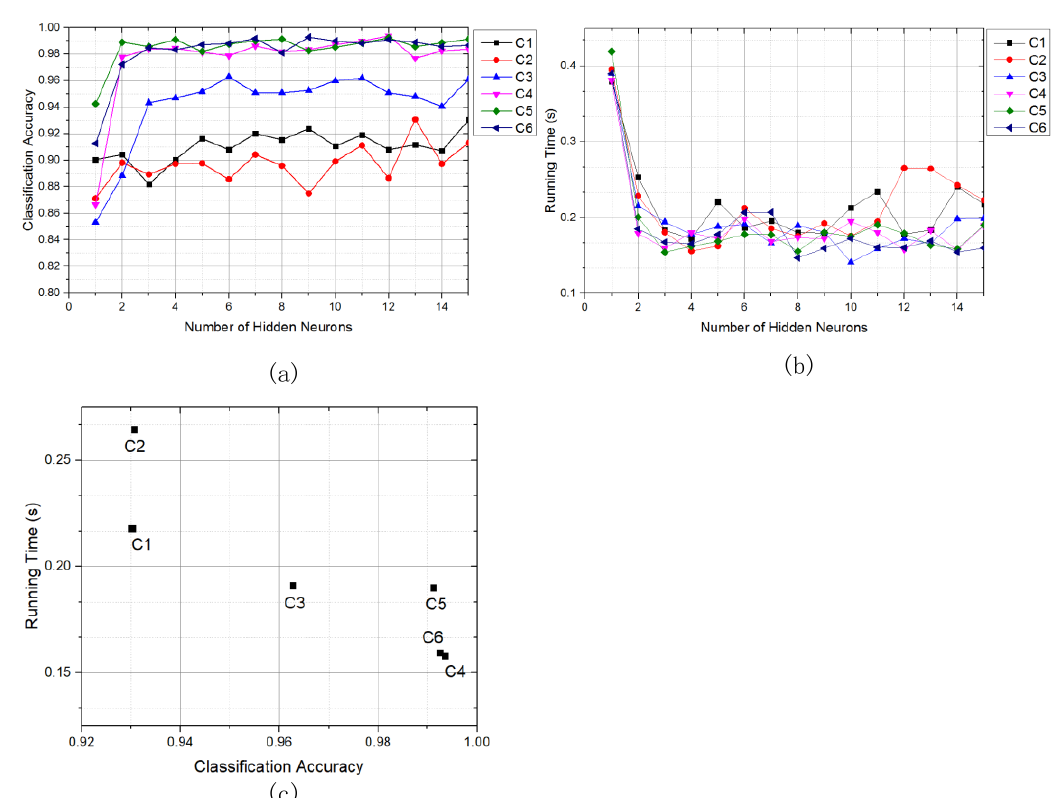
Figure 3. (a) The classification accuracy and (b) running time of ANN with respect to different numbers of hidden neurons; (c) the relationship between running time and classification accuracy of the best performance of six feature combinations